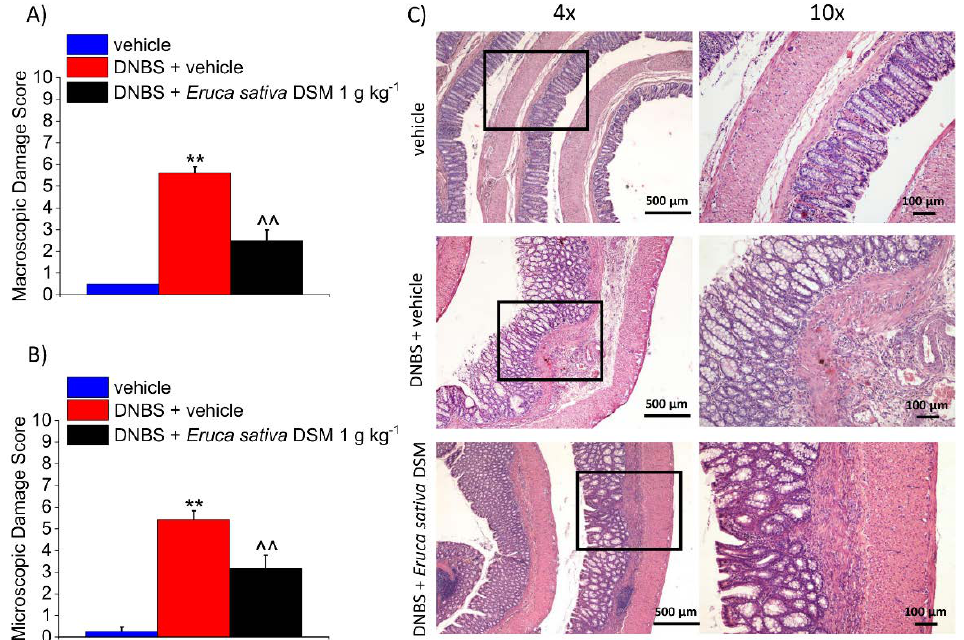
Figure 5. The effect of the repeated treatment with Eruca sativa DSM on colon damage induced by DNBS in rats. Eruca sativa DSM (1 g kg − 1 ) was administered once daily in the DNBS-treated animals, starting from the day of DNBS injection for 14 consecutive days, then tissues were collected. Colon macroscopic ( A ) and microscopic ( B ) damage score; Representative pictures of haematoxylin-eosin stained sections of full-thickness colon ( C ). Original magnification: 4 × and 10 × . Each value represents the mean ± SEM of 6 animals per group. ** p < 0.01 vs. vehicle. ˆˆ p < 0.01 vs. DNBS + vehicle.